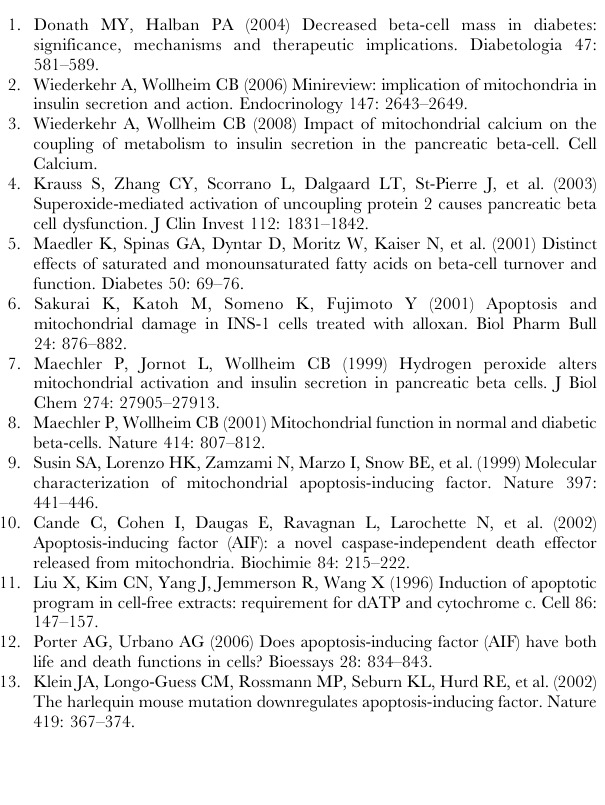
Figure 3. AIF depletion leads to increased b -cell apoptosis in human islets without affecting insulin secretion. (A) Isolated human pancreatic islets were exposed to siRNA to AIF (siAIF) or scrambled control siRNA (siScr) for 3 days. The knockdown efficiency was determined by Western blot analysis. Actin was used as a loading control on the same membrane after stripping. This Western blot is representative of three independent experiments from three different organ donors. The density of expression levels were quantified after scanning and normalised to actin levels. (B – D) 3 days after transfection, islets were exposed to 50 m M H 2 O 2 for 2 h. (B) Islet sections were prepared for analysis of b -cell apoptosis by the TUNEL assay. Islets were double-stained for insulin in green and counterstained for DAPI in blue. Results are means 6 SE of the percentage of TUNEL-positive b -cells. The mean number of b -cells counted was 3400 for each treatment condition. (C,D) GSIS: after the H 2 O 2 treatment, islets were washed and basal and stimulated insulin secretion analyzed during successive 1-h incubations at 2.8 mM (basal) and 16.7 mM (stimulated) glucose. Data are normalized to insulin content. (D) Stimulatory index denotes the ratio between stimulated and basal values of insulin secretion. (B–D) All assays were performed in triplicate or quadruplicate in three independent experiments from 3 different organ donors, respectively. *p , 0.05 to siScr control, ** p , 0.05 in H 2 O 2 treated vs. untreated control.